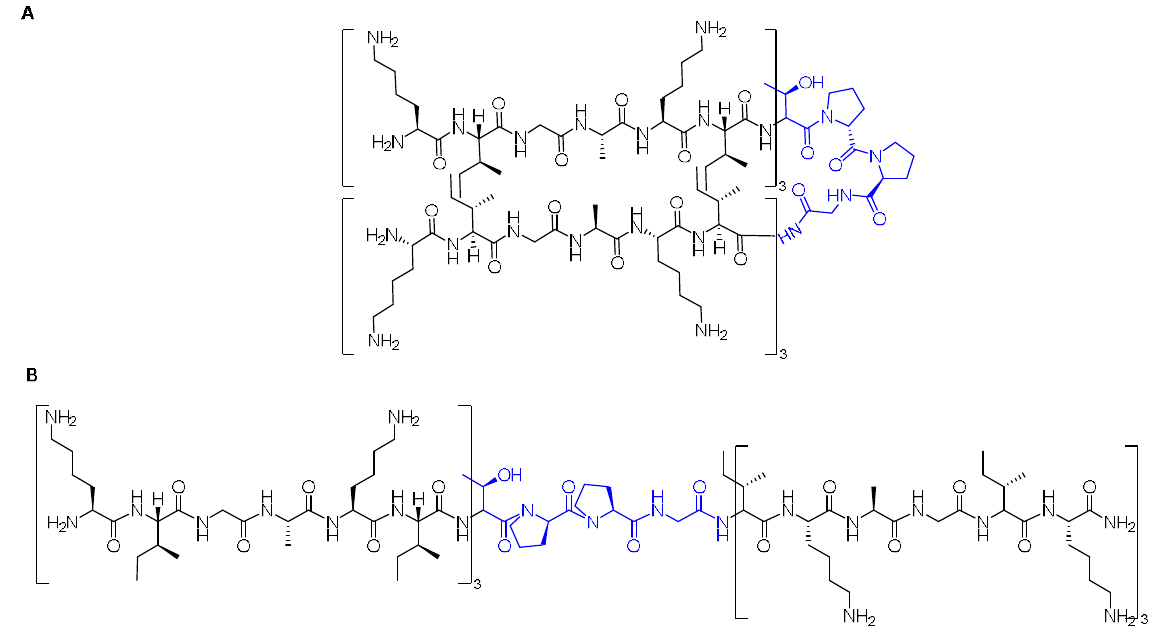
Figure 14. Chemical structure of: ( A ) ASCP1; ( B ) ASCP2. The linker is shown in blue. By balancing the electrostatic repulsion of the Lys residues and the hydrophobic interactions of Ile and Ala residues, and in response to stimuli such as pH, heat, and ionic strength, the formation of individually dispersed nanofibers can occur. At a concentration of 5 mg/mL in an aqueous solution, ASCP1 is able to self-assemble, producing a transparent hydrogel. The predominant β -sheet was confirmed through Congo red testing, which is responsible for fiber network formation. At a concentration of 0.1 mg/mL, ASPC1 also showed a predominant presence of β -sheet at pH 11, also confirmed by CD, where a sharp minimum at 216 nm was observed. Moreover, FTIR was also carried out, and